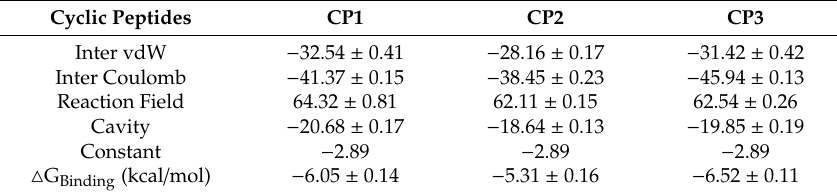
Table 5. Information of SIE free energy calculations for UEV domain protein.